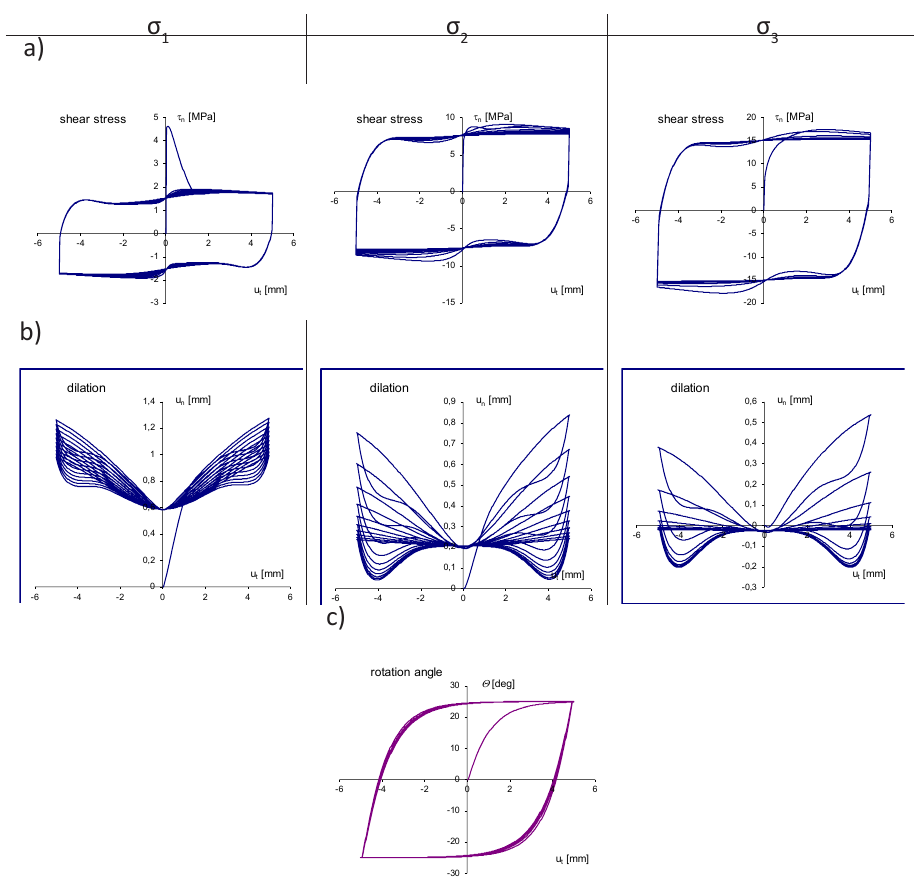
< σ < σ , ρ = 2.3 10 3 kg/m 3 , q = 25° , asperity degradation , interface layer 1 2 3 ini max : a) variations of shear stress, b) variations of dilatancy, c) variations of rotation t